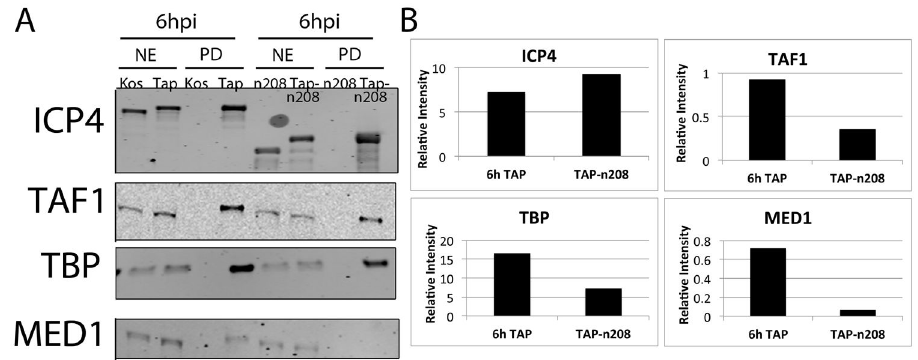
Figure 6. TAP-n208 associates with both TFIID and Mediator. ( A ) Western blot analysis of nuclear extracts (NE) or affinity purified (PD) samples collected at 6 hpi using either wtICP4 (KOS), TAP-wtICP4 (TAP), the C-terminal truncation mutant (n208) or a TAP-tagged C-terminal truncation mutant (TAP-n208) expressing viruses. Antibodies directed against ICP4, TAF1 and TBP of TFIID, and Med1 of Mediator were used. ( B ) Quantification of the western blots in (A). Images were quantified using the LiCOR Odyssey infrared imager and normalized to the amount of ICP4 present within the sample. doi: